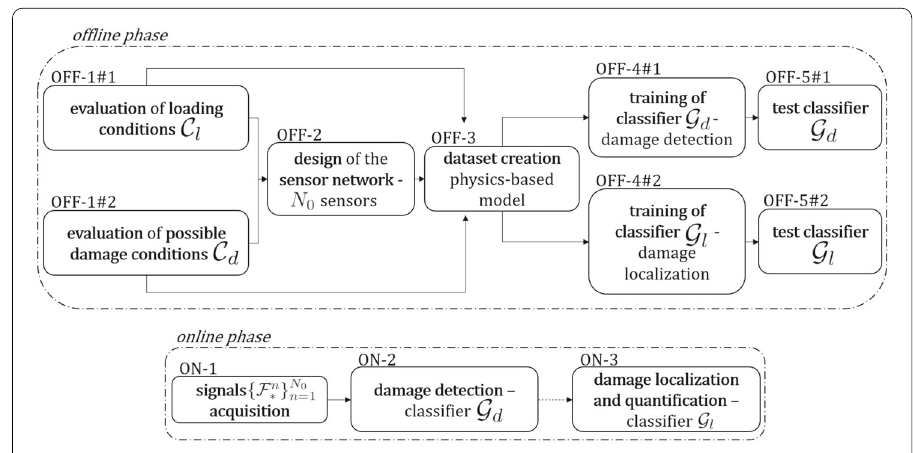
Fig. 1 SBC + FCN classifier. The offline phase is performed before the start of operations of the structure, while the online stage during its normal